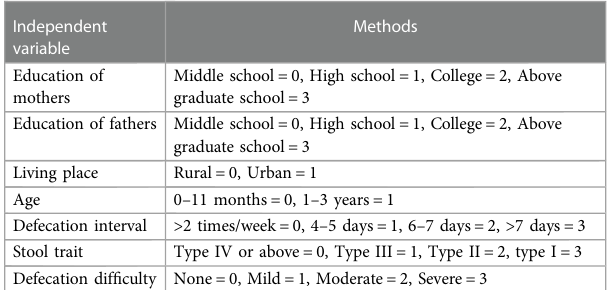
TABLE 5 Independent variable assignment